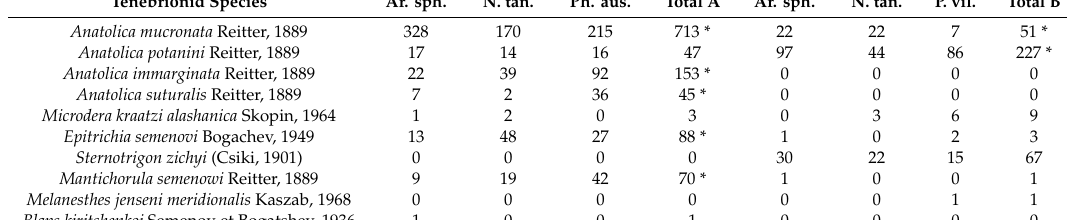
Table 1. Number of collected tenebrionid beetles beneath tufts of four plant species in two sites in the Ulan Buh Desert (Gobi Desert, Inner Mongolia). Plant names: Ar. sph. = Artemisia sphaerocephala ;